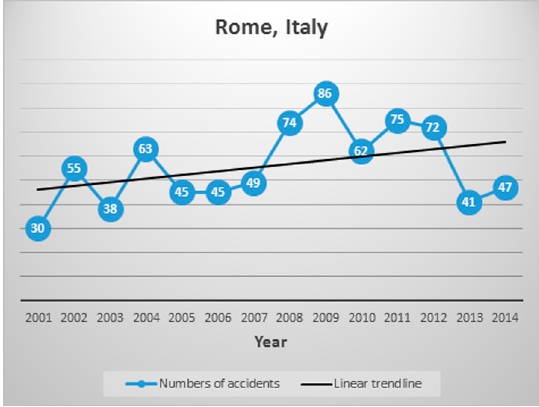
Figure 1. Upward trend of serious accidents where tree root cracking or lifting of asphalt pavement resulted in injured and deceased victims in the city of Rome from 2001 to 2014 [22].